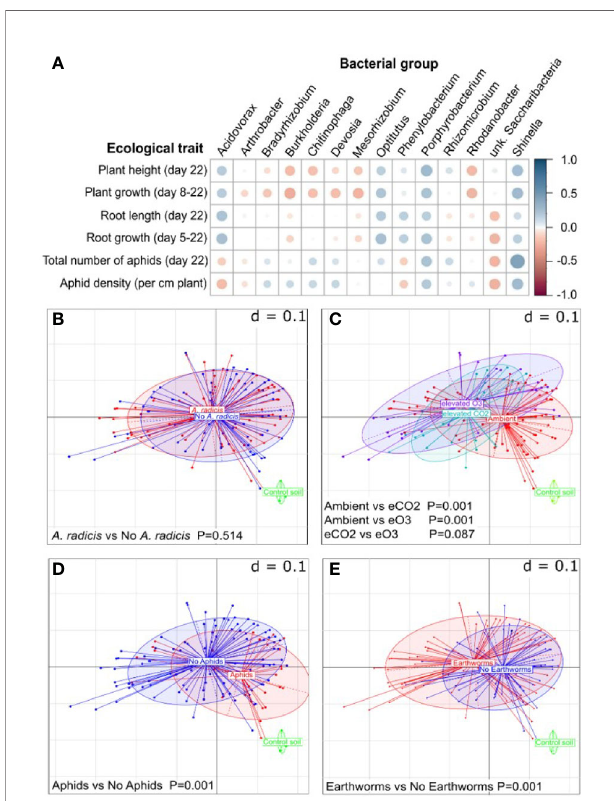
FIGURE 3 | Changes in the plant root microbiome (16S analysis). (A) Correlation plot showing negative (red) and positive (blue) correlations between different measured plant parameters and the abundance of detected genera. The bigger the circle the higher the signi fi cance (i.e., the lower the p- value), cutoff was set to p=0.05. (B – E) Multi-dimensional scaling plots of microbial pro fi les with d=0.1 meaning that the distance between two grid lines represents approximately 10% dissimilarity between the samples, when separated by (A) A. radicis inoculation, (B) climate treatment, (C) aphid infestation, and (D) earthworm